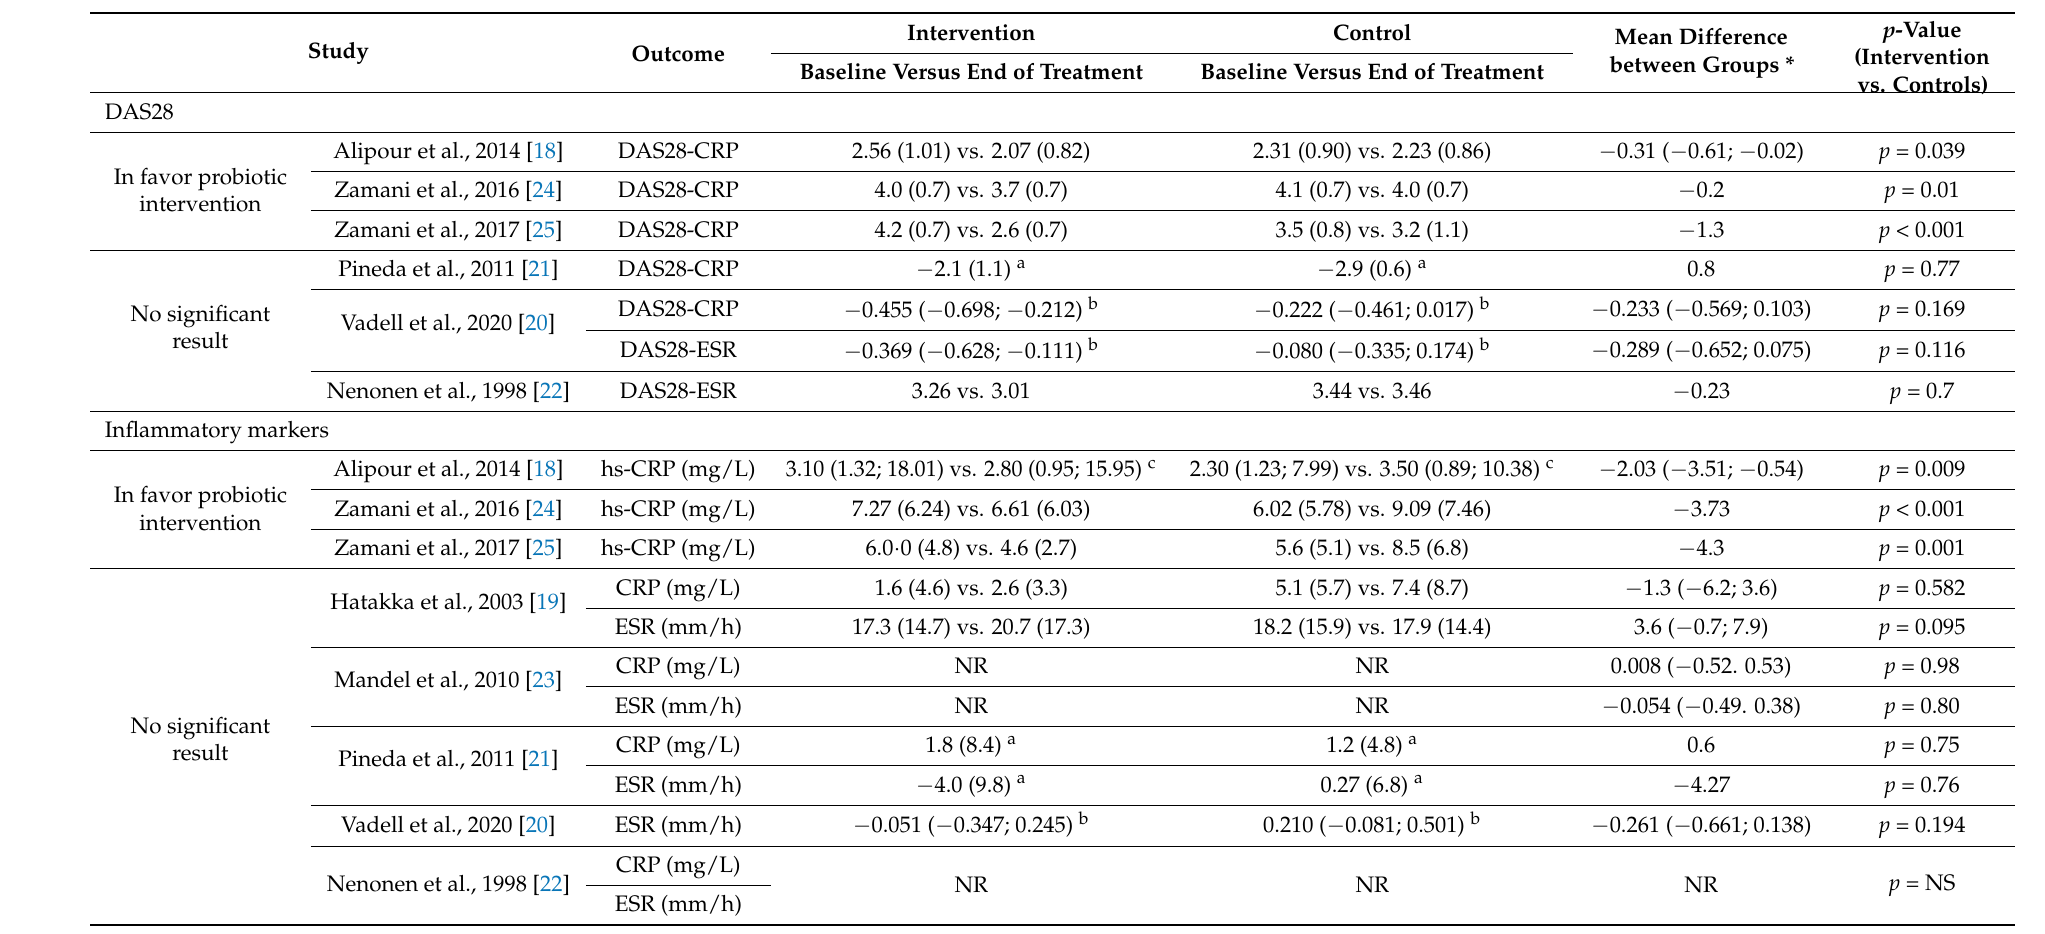
Table 3. Study results sorted by covariates in rheumatoid arthritis. Intervention Control Mean Difference Outcome Controls)Baseline Versus End of Treatment Baseline Versus End of